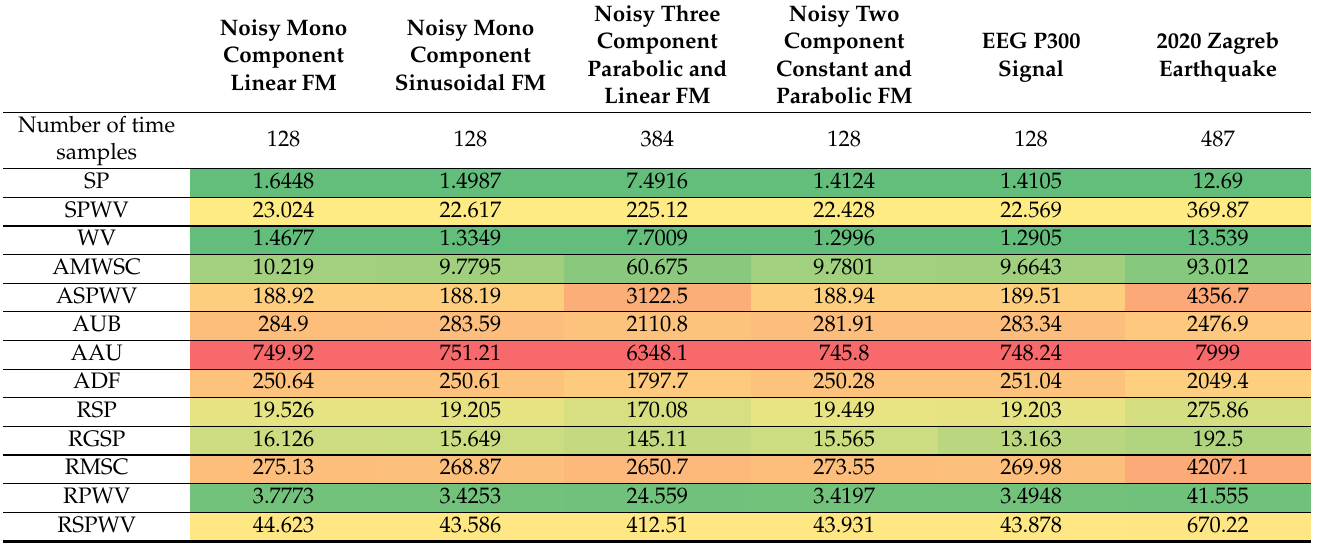
Table 11. Computation time for analyzed TFRs for tested signals (averaged over 100 realizations, SNR of 5 dB), cell colors range from green for the best result to red for the worst result in each column respectively, in milliseconds (ms).